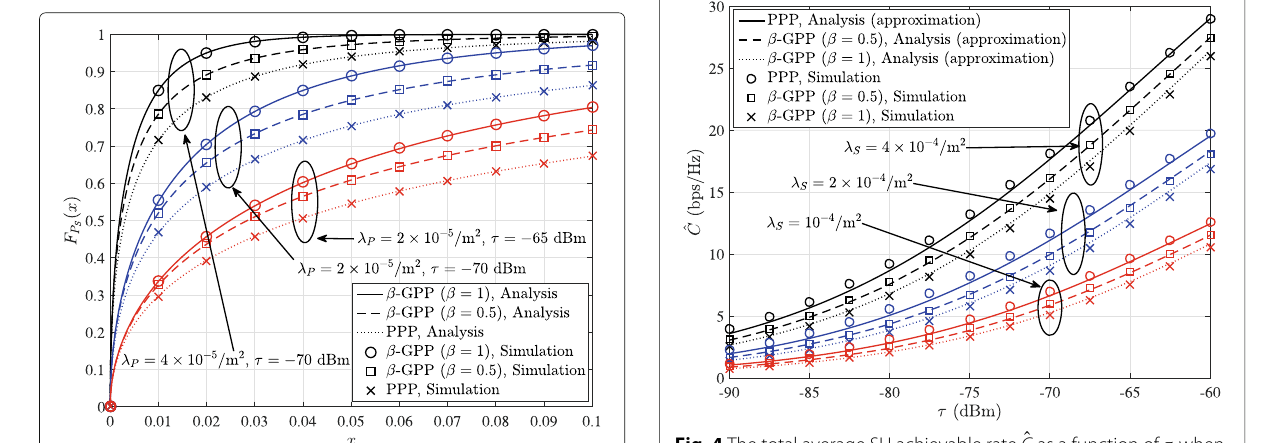
Fig. 4 The total average SU achievable rate ˆ C as a function of τ when the DSA is applied at the